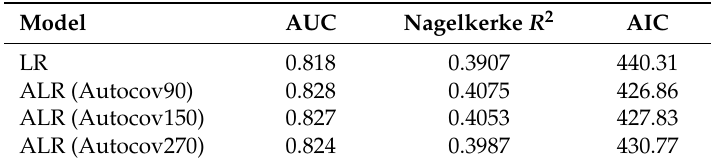
Table 6. Model selection for autologistic